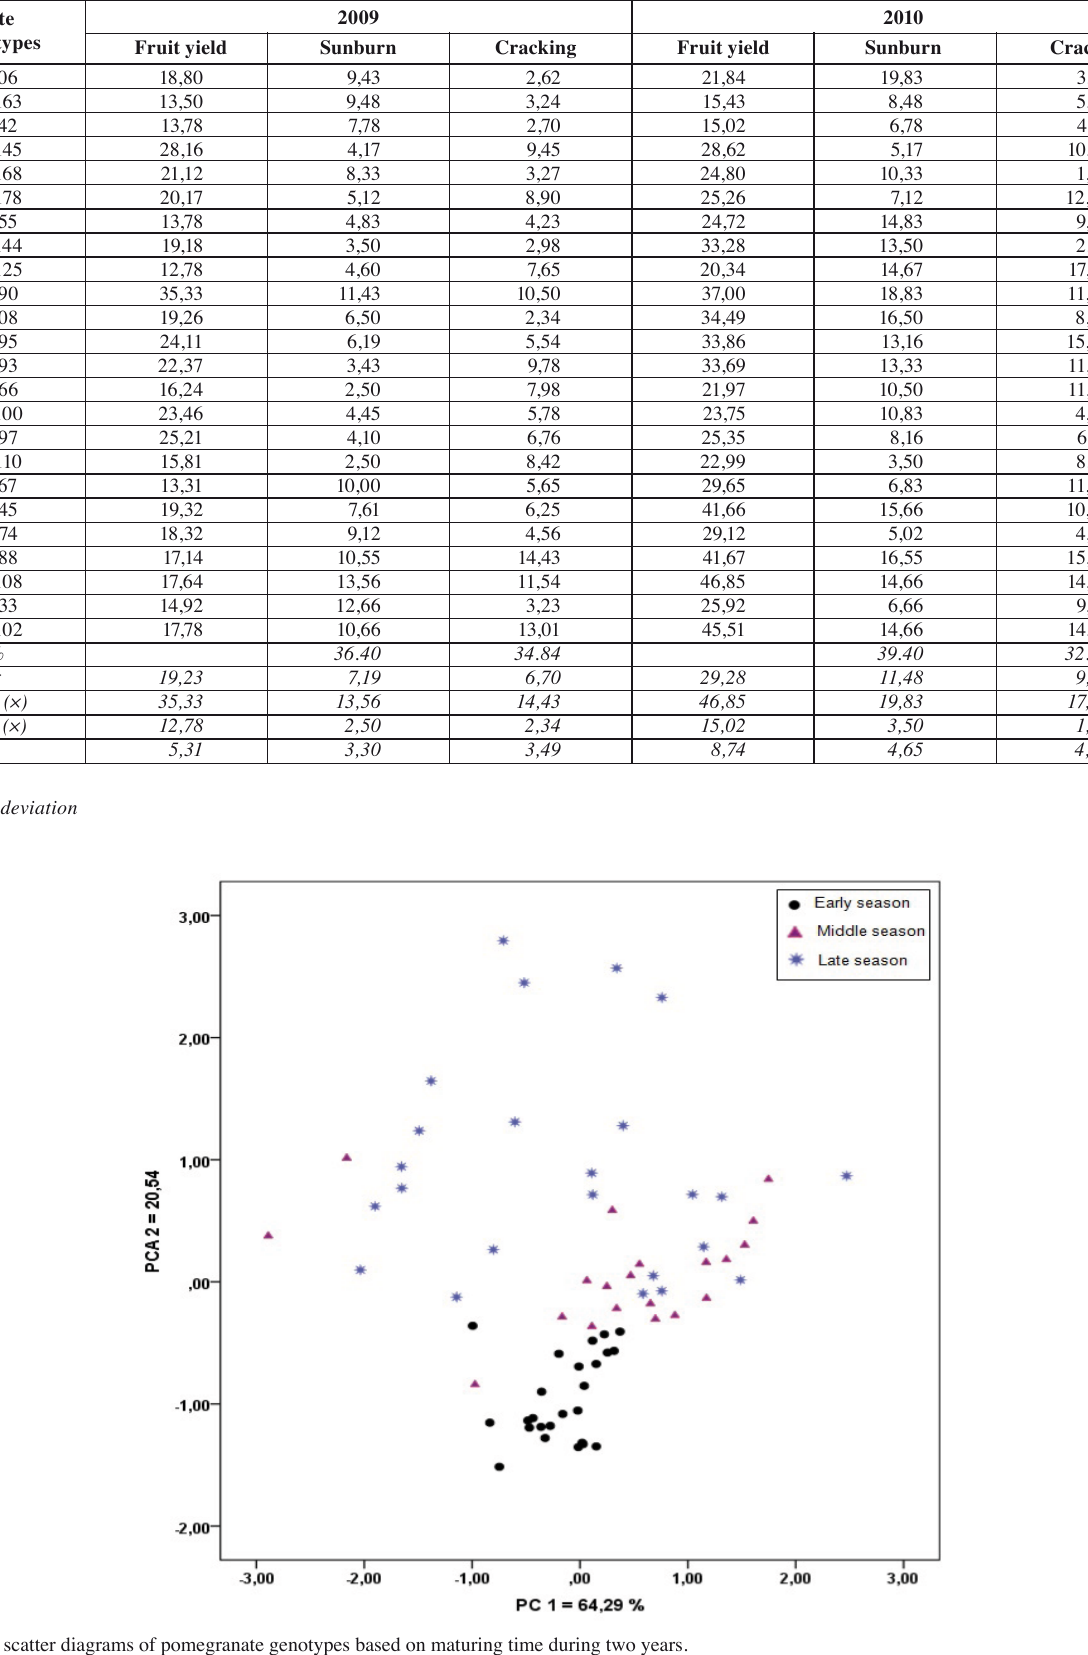
Fig. 3: 2D scatter diagrams of pomegranate genotypes based on maturing time during two